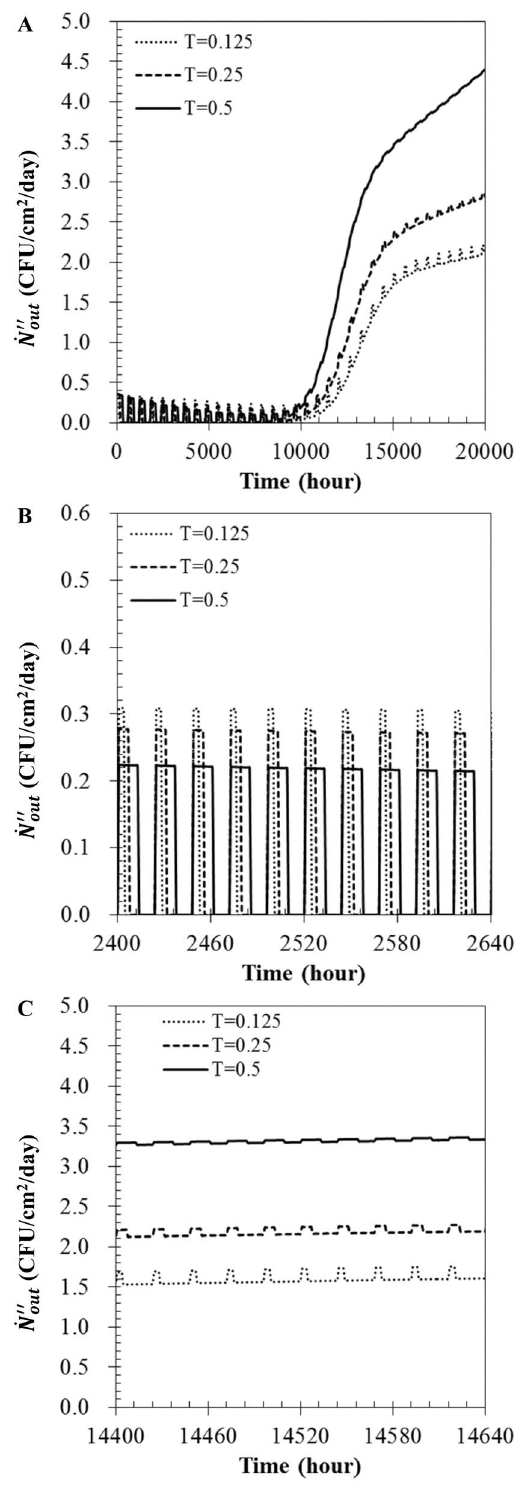
Figure 8. Bioaerosol number flux with various cycles of 00 , (B) details in initial phase (C) details in stationary operation. (A) _ NN out phase when g anti = 0.5, Q = 1.0 m 3 /sec, C in = 100 m g/m 3 , and w nutrient =0.01.